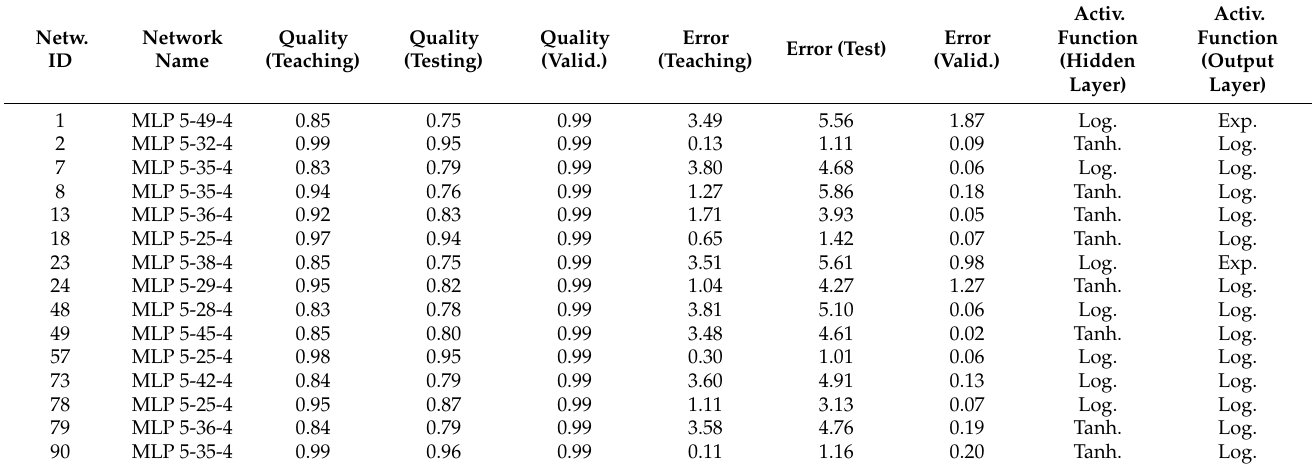
Table 5. Examples of a teaching process of selected neural networks.